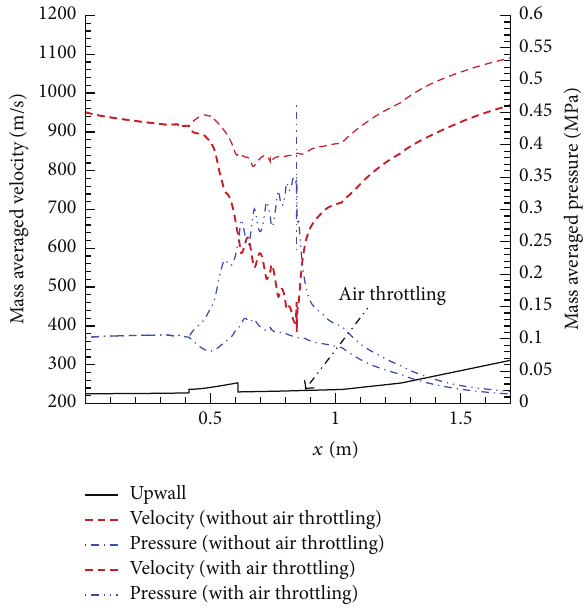
Figure 4: Mass averaged velocity and pressure of the scramjet com- bustor with and without air throttling.